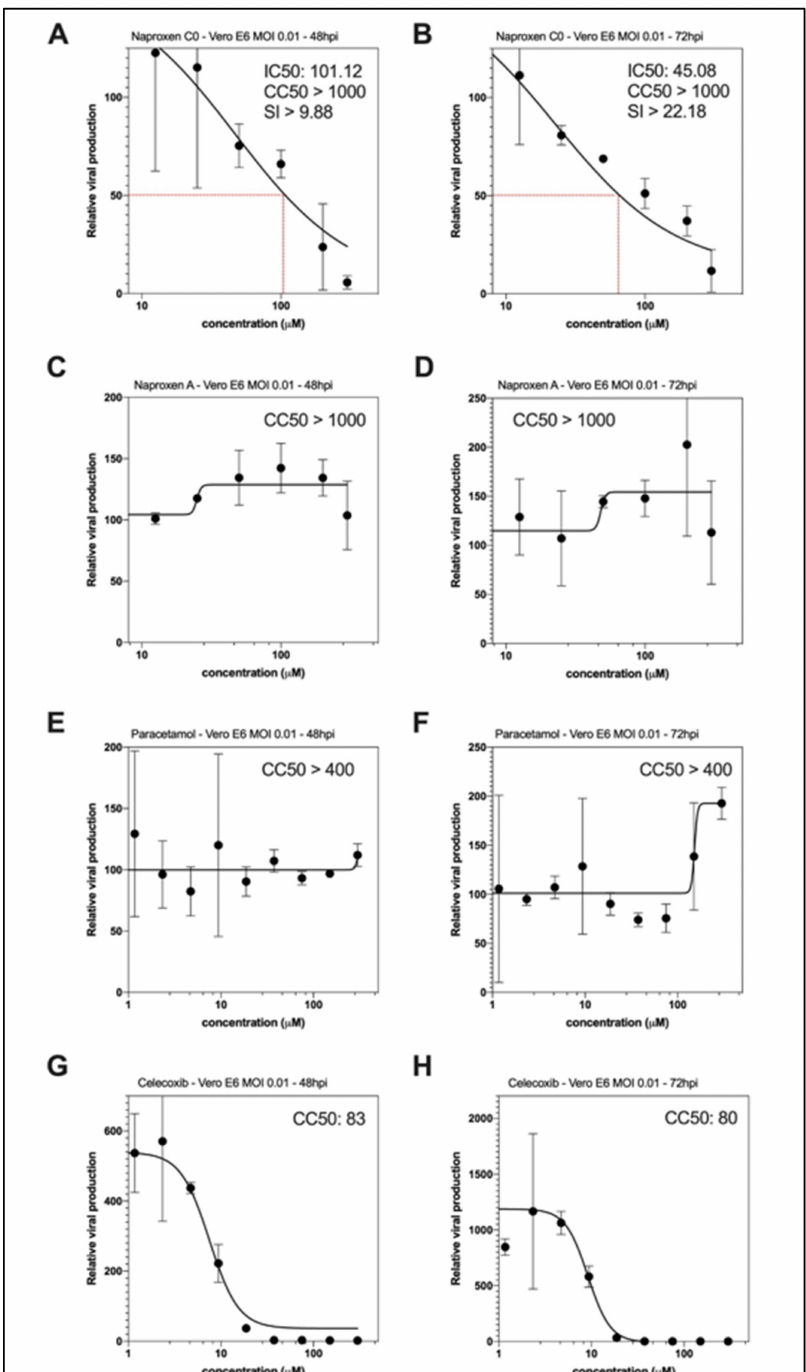
Figure 7. Antiviral effect of naproxen C0, as compared to the naproxen A derivative, acetaminophen and the COX2 inhibitor celecoxib in infected Vero E6 cells. Dose–response curves of naproxen C0 ( A , B ) or naproxen A ( C , D ) at 48 and 72 hpi in infected Vero E6 cells. Using the same experimental protocol as in Figure 4, Vero E6 cells were infected at MOI 0.01 with SARS-CoV-2 and then treated 1h postinfection with a large range of concentration of naproxen C0 or A or paracetamol or celecoxib. Panels ( E , F ) and ( G , H ) show the lack effect of acetaminophen (paracetamol) and the mainly proviral effect of celecoxib (COX2 inhibitor) on viral replication, demonstrating the specificity of naproxen among the COX inhibitors tested (Table